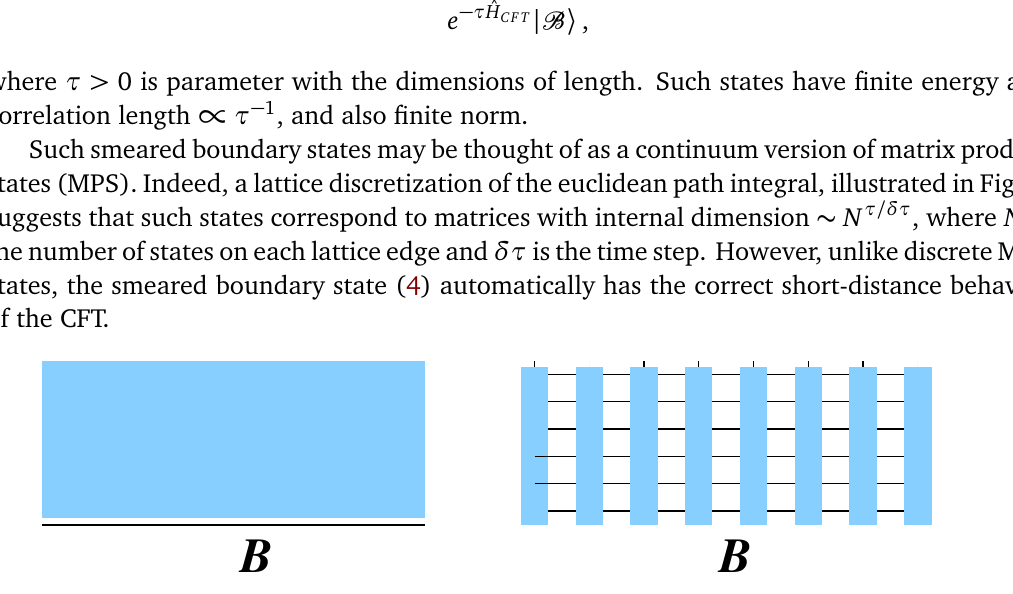
Figure 1: Path integral for smeared boundary state (left) and its lattice discretization (right) as a matrix product state. On the right, each vertical column of lattice sites represents a matrix. The horizontal lines represent contractions between these in the internal space, and the vertical dangling bonds label the physical degrees of